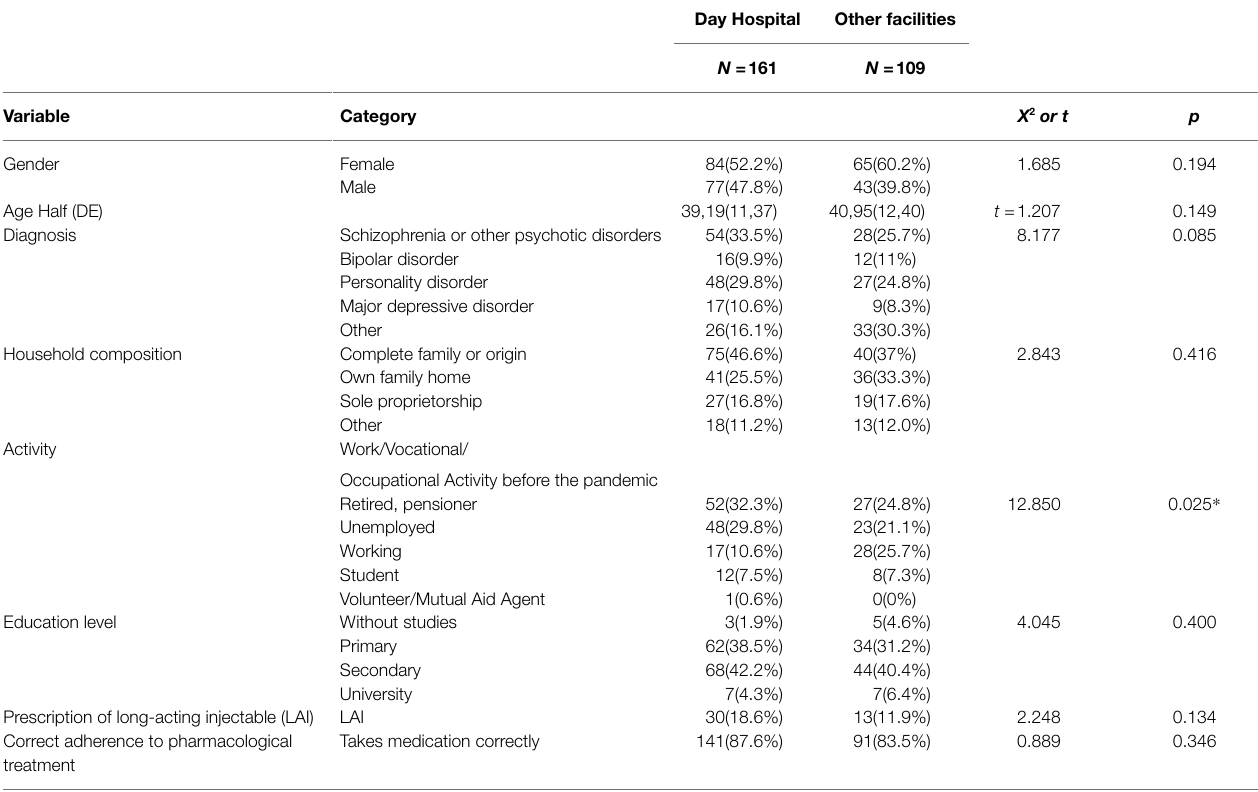
TABLE 1 | Sociodemographic and clinical